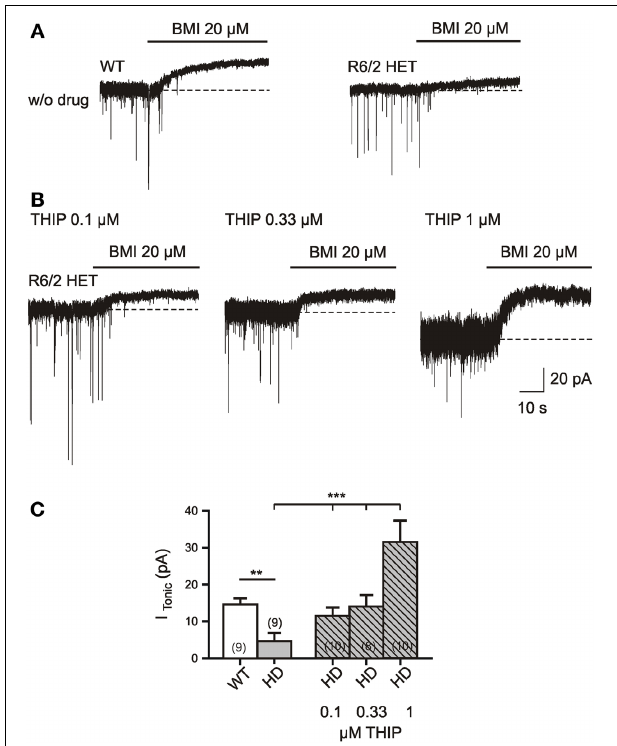
FIGURE 6 | Rescue of I Tonic ( GABA ) in R6/2 HD mice by bath application of THIP (gaboxadol) at a concentration of 0.33 µ M. (A,B) Specimen records in the absence (A) and presence (B) of delta subunit specific GABA(A) receptor hyper-agonist THIP (0.1 µ M, 0.33 µ M, and 1 µ M). The recording conditions were similar to those in Figure 1 . Experiments were performed in the presence of TTX (1 µ M), DNQX (10 µ M), APV (50 µ M), LY341495 (40 µ M); no K channel block; V h = − 70mV, E Cl = 4mV. THIP was applied through a slow drug delivery system to the bath solution (exchange time ca. 1min). (C) Quantification of the results. The asterisks denote the following: ∗ p < 0 . 05, ∗∗ p < 0 . 01, and ∗∗∗ p < 0 . 001. The comparison between WT and HD was performed by the Mann–Whitney test. The THIP effect on HD SONs was tested by One-Way ANOVA (multiple comparison against the “THIP0” group) and resulted in F ( 3 , 33 ) = 9 . 731, p < 0 . 0001 for the THIP concentrations 0, 0.1, 0.33, and 1 µ